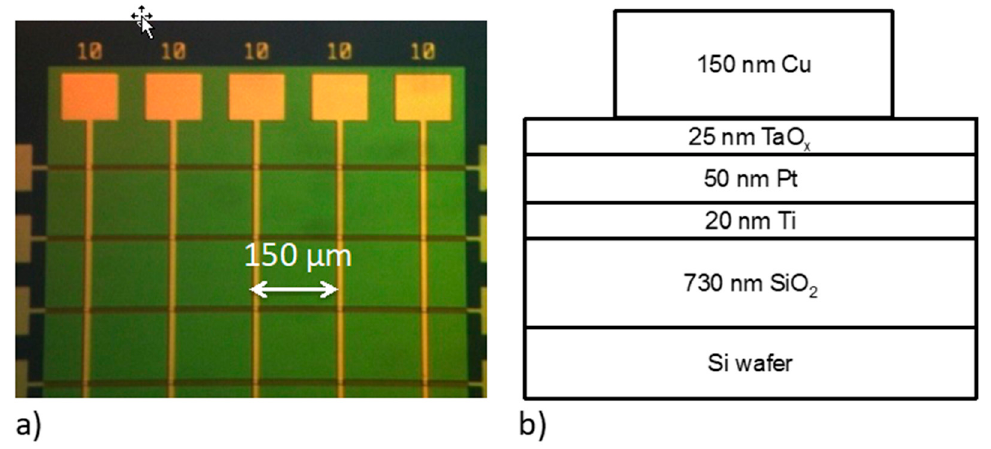
Figure 1. ( a ) Optical micrograph of the crossbar architecture of Cu/TaO x /(Pt and Ru) devices; ( b ) cross ‐ section of the device with relevant layer thicknesses indicated.